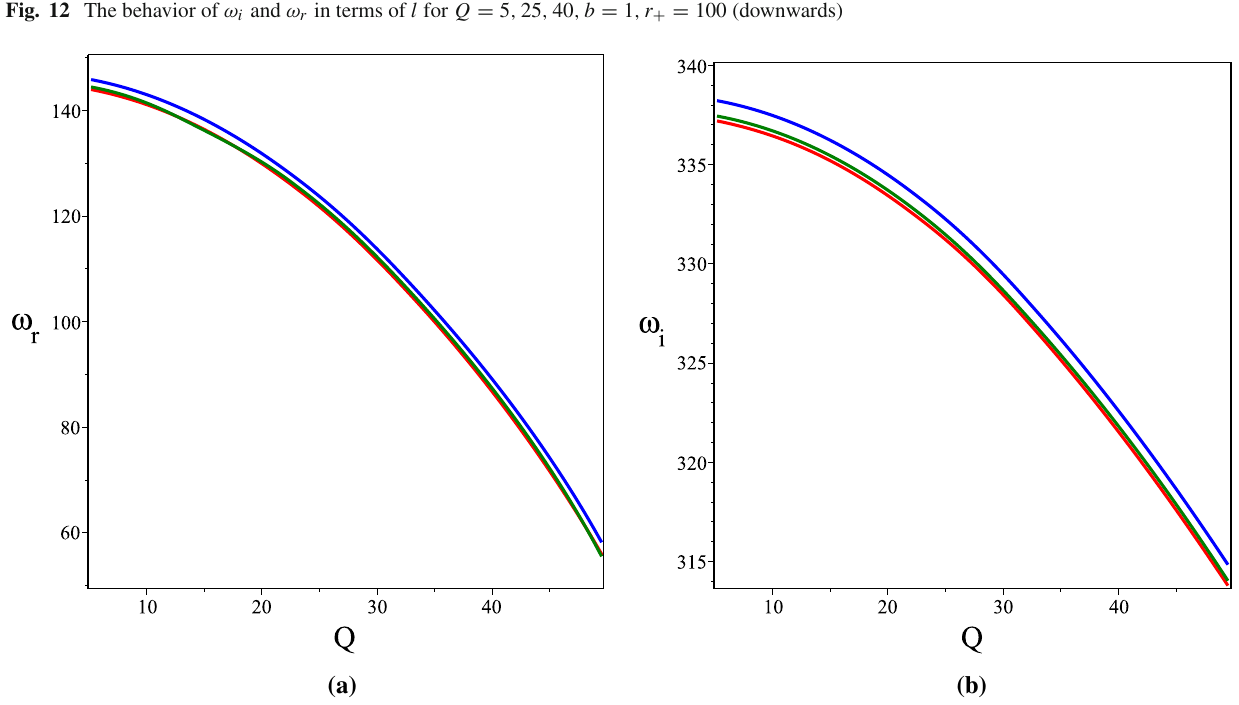
Fig. 13 The behavior of ω r and ω i in terms of Q for l = 0 , 10 , 20 , b = 1 , r + = 100, (upwards)